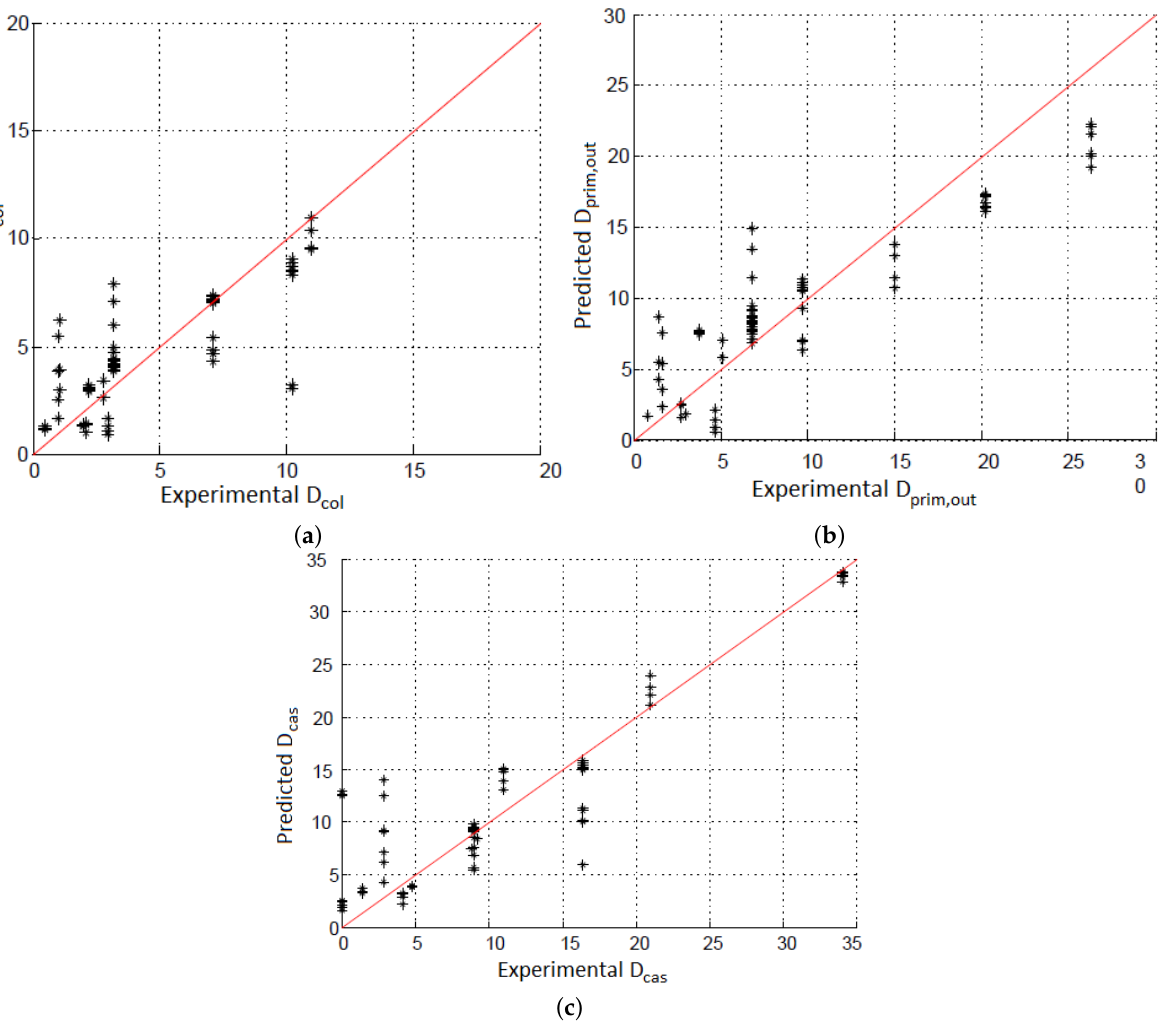
Figure 9. Predictions of the ANN model in terms of: ( a ) D col , ( b ) D prim , out , and ( c ) D cas for Case